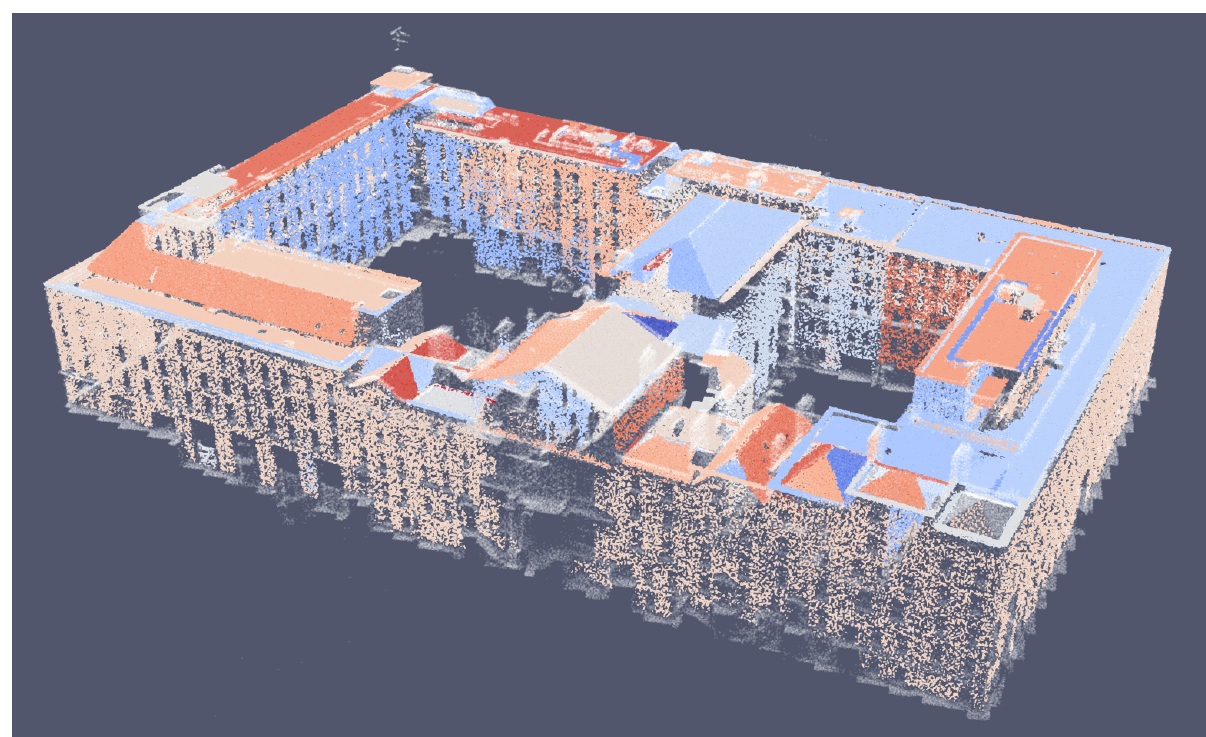
Figure 4. The results planes of plane segmentation for one building : Each of the planes is marked with a unique color. It can be seen that most of the surface planes were found with some smaller pieces missing.